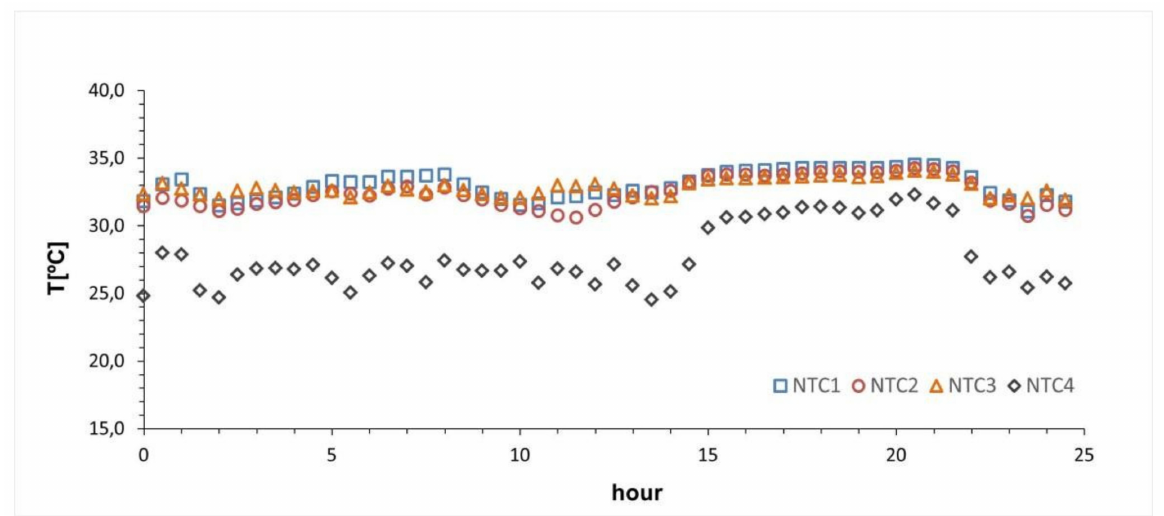
Figure 20. Temperature data recorded over a 24 h period. NTC1 = skin lesion, NTC2 = perilesional skin, NTC3 = healthy skin, and NTC4 =